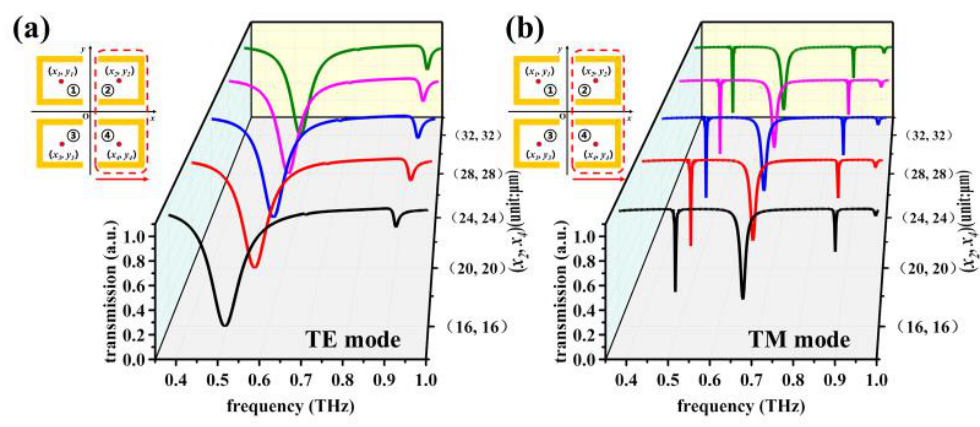
Figure 2. Simulated transmission spectra of the RTM device obtained by moving the SRR-2 and SRR-4 meta-atoms along the positive x -axis direction in ( a ) transverse electric (TE) and ( b ) transverse magnetic (TM) modes.